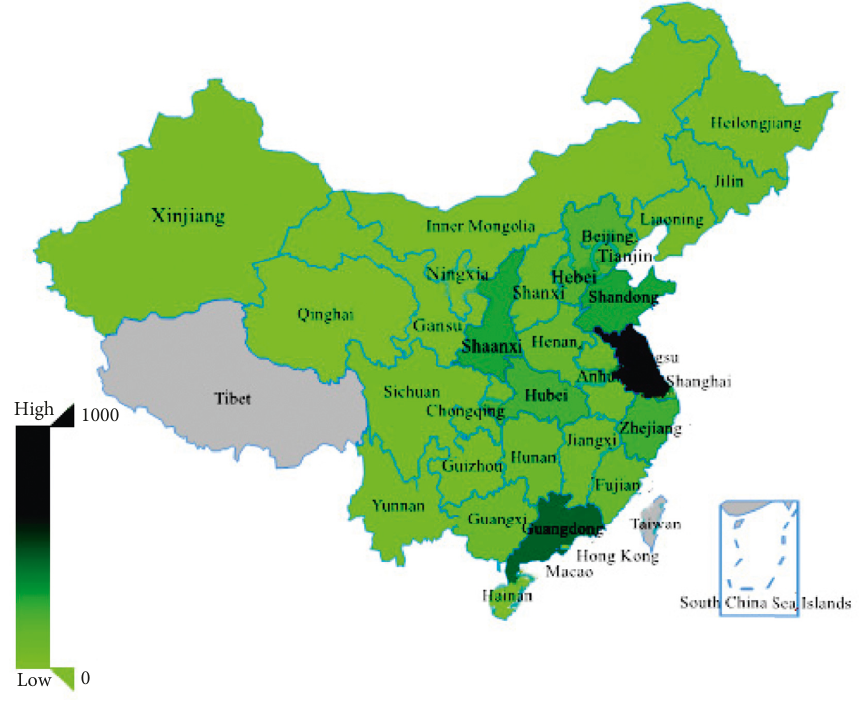
Figure 2: Green building evaluation marking project map.